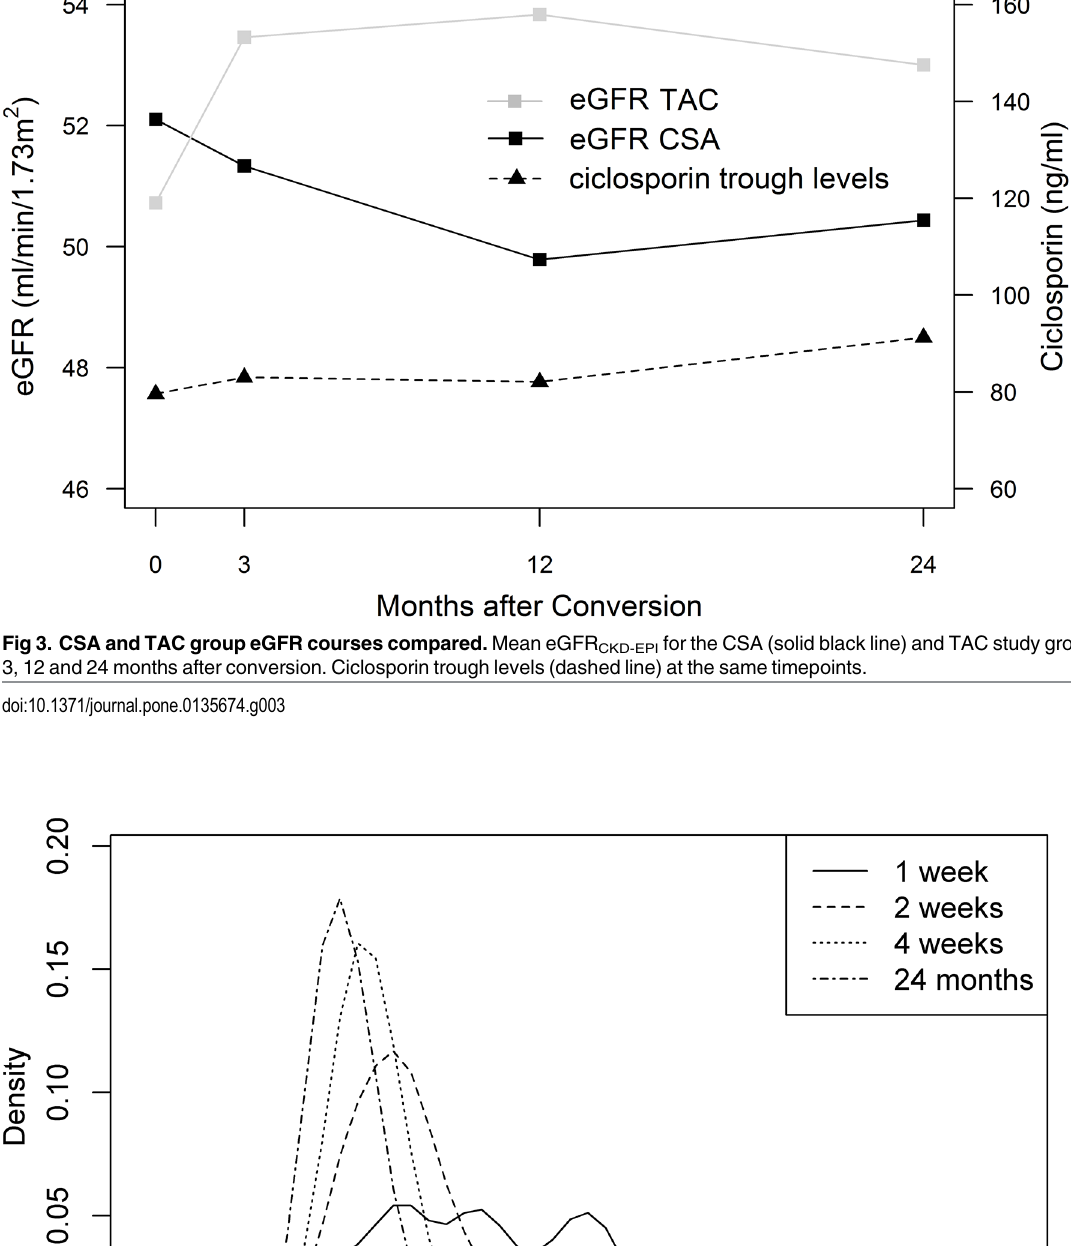
PLOS ONE | DOI:10.1371/journal.pone.0135674 August 13, 2015 8 /